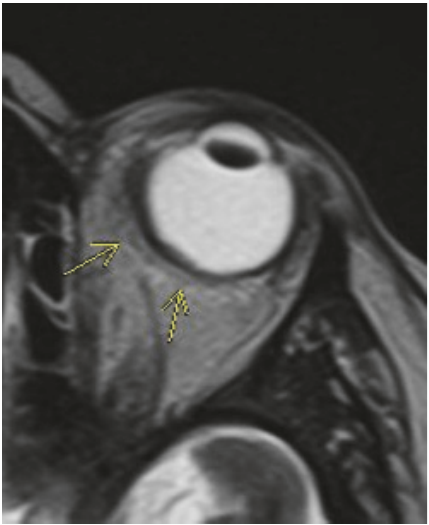
Figure 2: Axial T2 weighted image through the left orbit demon- strating irregular thickening of the posterior and medial wall of the left